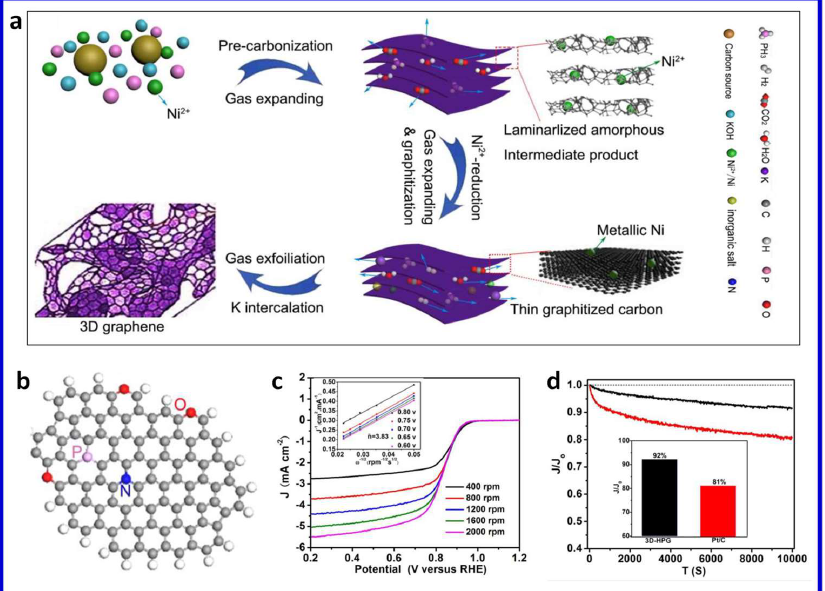
Figure 7. ( a ) Schematic process for synthesis of N-P-O co-doped 3D-HPG; ( b ) Schematic model of 3D-HPG; ( c ) ORR polarization curves for 3D-HPG at different rotating rates in O 2 -Saturated 0.1 M KOH solution at scanning rates of 5 mV·s −1 , inset: K–L plots; ( d ) The current vs. time (i-t) chronoamperometric responses of 3D-HPG and Pt/C in O 2 -saturated 0.1 M KOH at a constant potential at 0.65 V (versus RHE) and a rotation rate of 1600 rpm, inset: the ratio of the J/J0. Reproduced from [99], Copyright 2016, Elsevier.